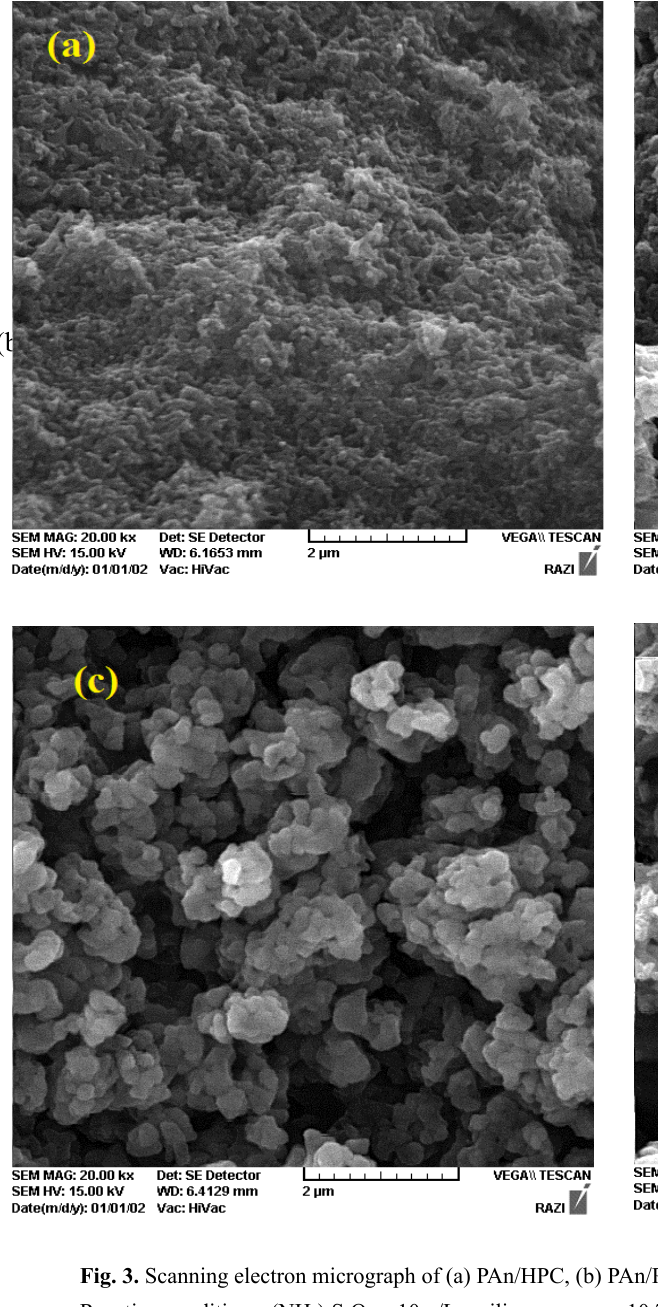
) S O = 10 g/L, aniline monomer 10.75×10 -2 mol/L, HPC, PEG, PVA, DBSNa = 4 4 2 2 8